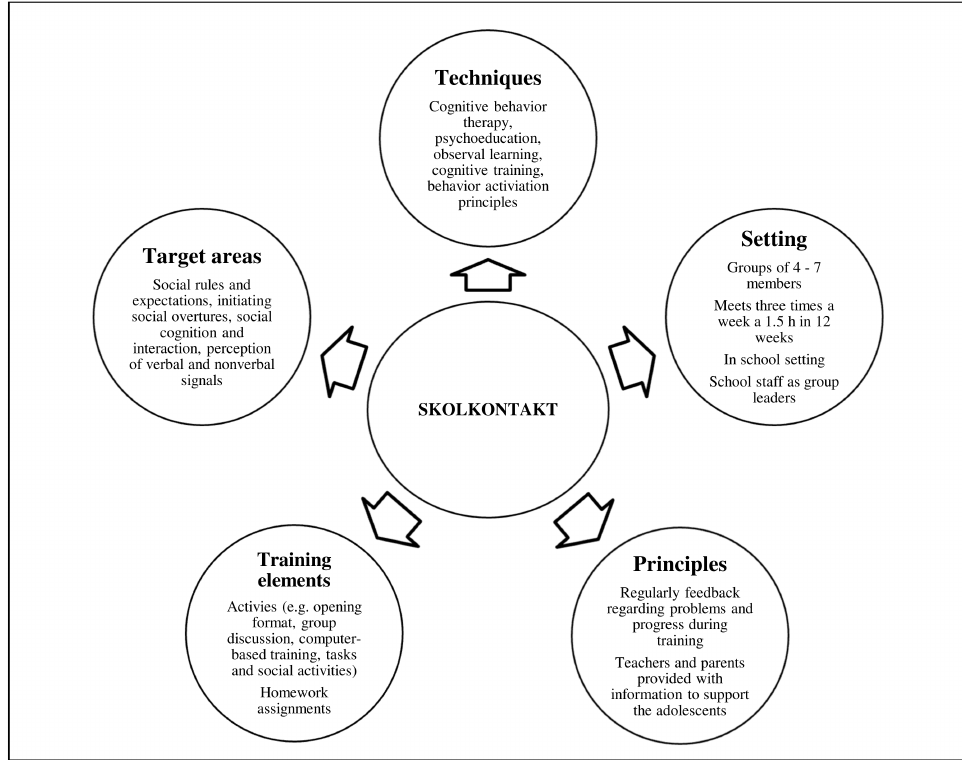
Figure 1. Characteristics of SKOLKONTAKT ®